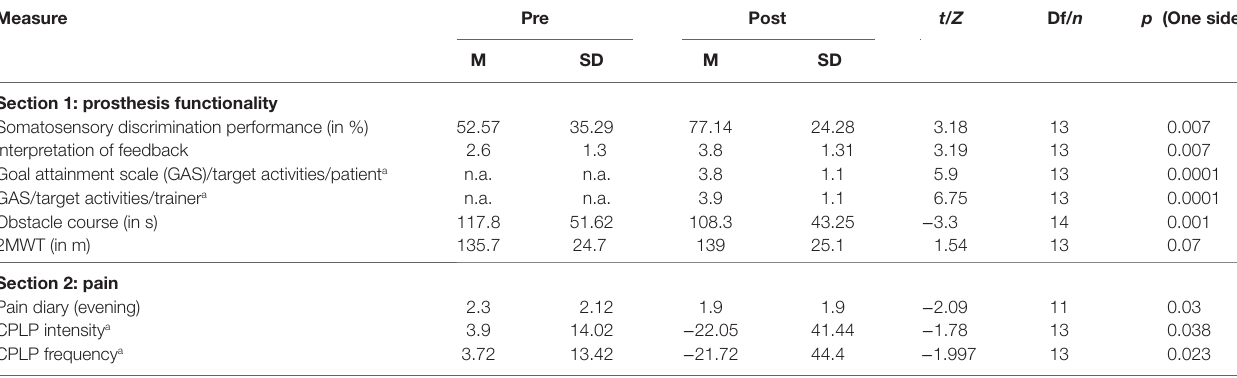
Table 2 | Summary of major statistical